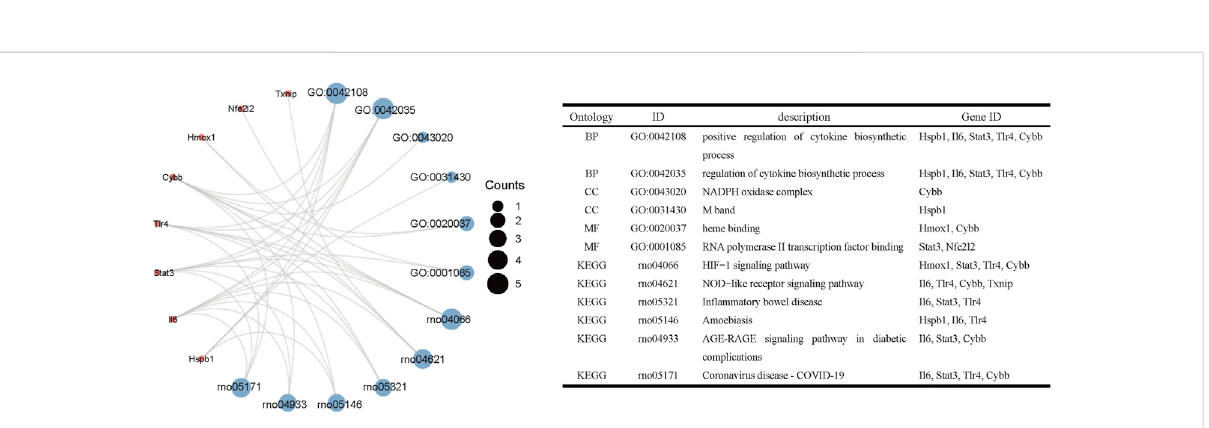
FIGURE 5 Functional enrichment analysis of genes in cluster